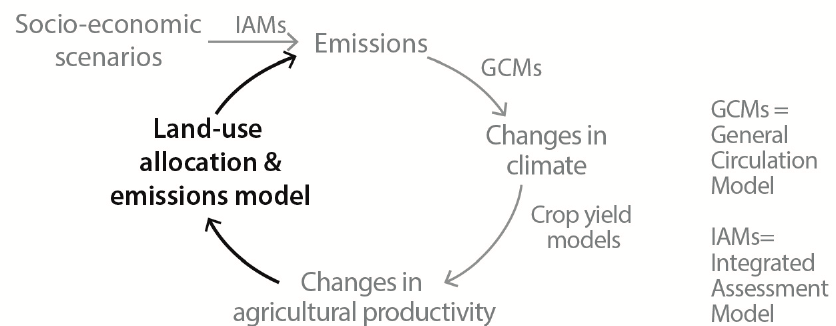
Figure 1. Schematic overview of the feedback loop between climate change and